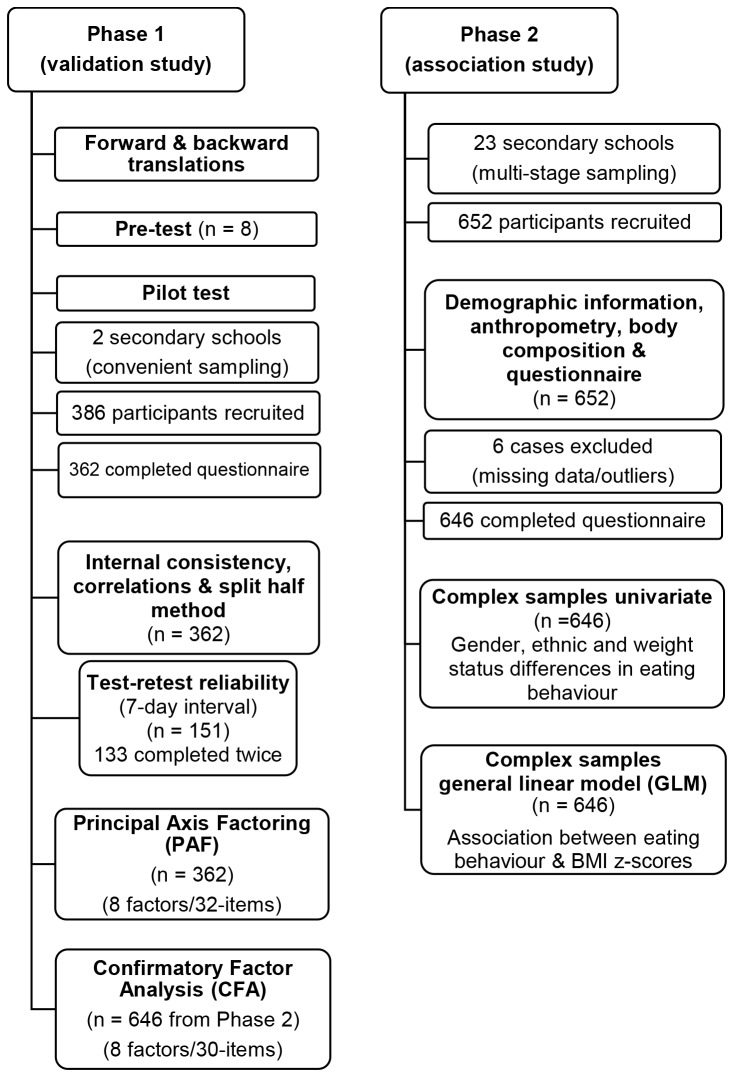
Flowchart of study procedures.